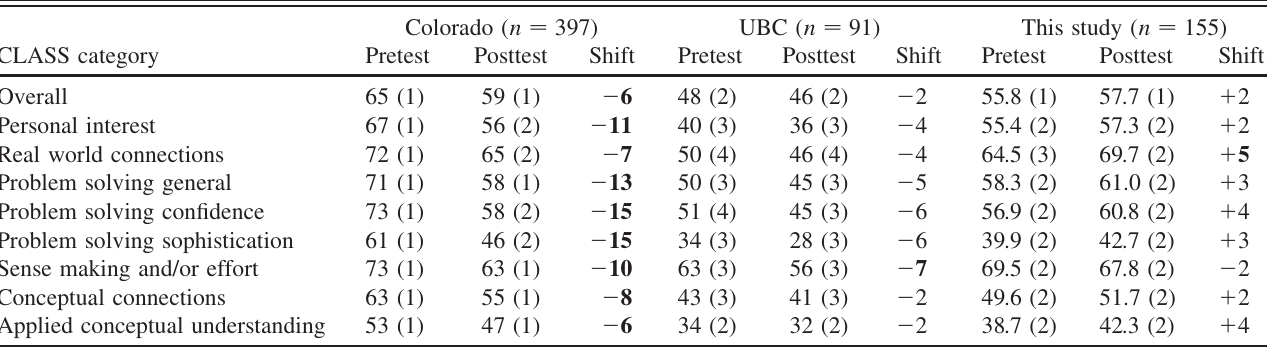
TABLE I. Comparison of week 2 and week 12 CLASS results with those from University of British Columbia (UBC) and the University of Colorado at Boulder. Average percentage of favorable responses (agree with experts) is shown, with the standard error of the mean in parentheses; differences that are statistically significant at the p < 0 : 05 level are shown in bold. UBC and University of Colorado results from Refs. [12,25]. UBC ( n ¼ 91 ) This study ( n ¼ 155